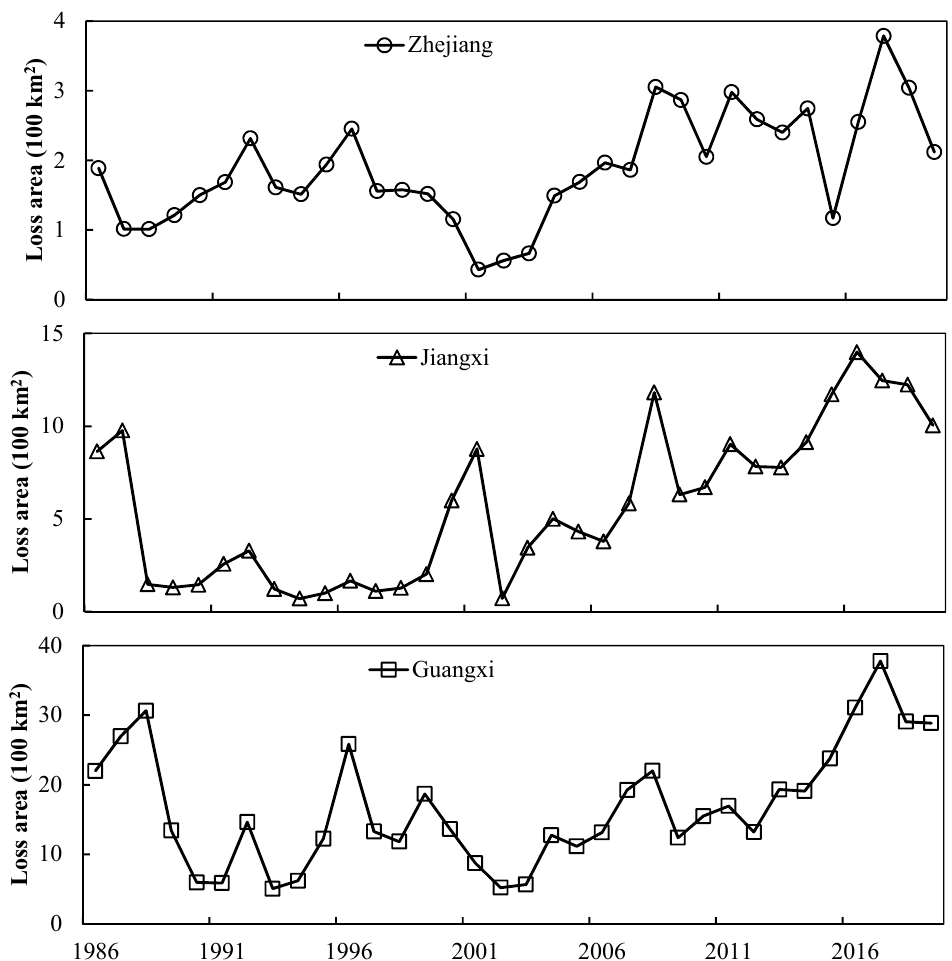
Figure 5. Interannual variations in detected forest loss area (km 2 ) in Zhejiang, Jiangxi, and Guangxi Province during 1986–2019.